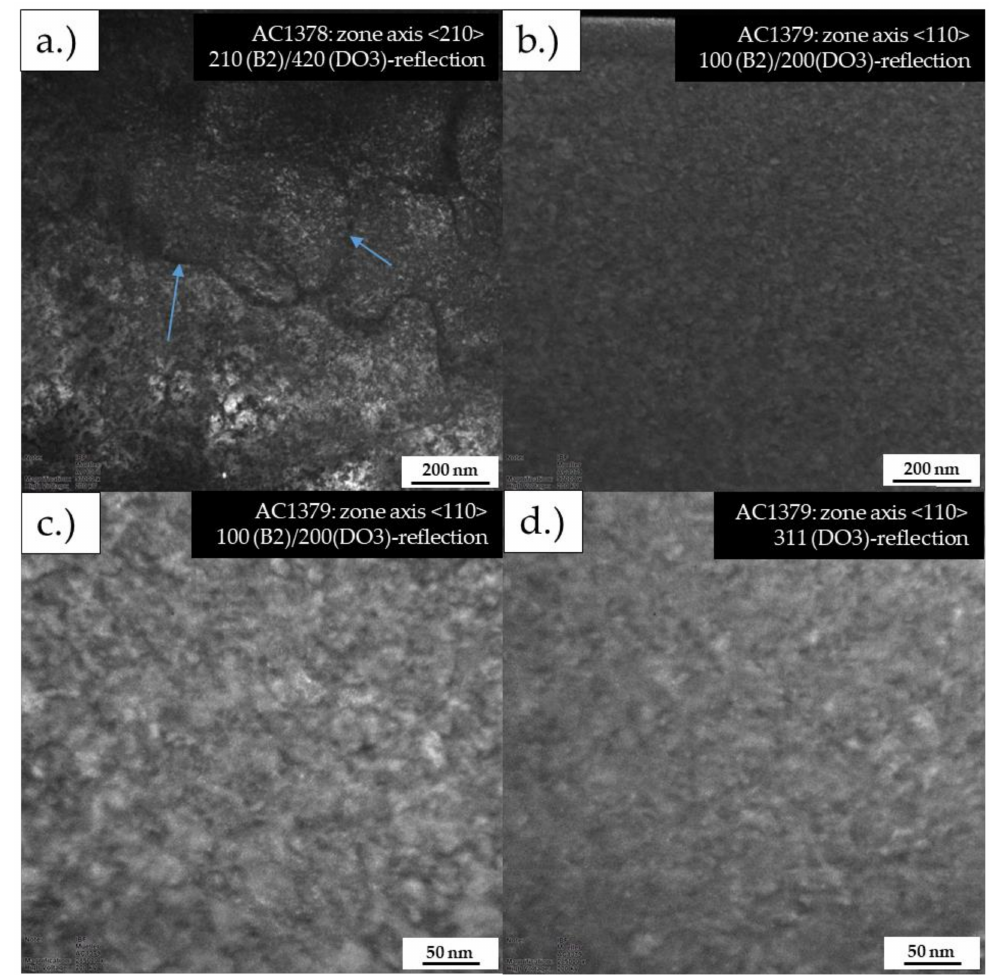
Figure 5. Dark field images received from TEM investigation: ( a ) AC1378 with a B2 and DO3 reflection; ( b ) AC1379 with a B2 and DO3 reflection; ( c ) magnified area of b with B2 and DO3 reflection and ( d ) same picture section as c with only DO3 reflection (Image source: GfE RWTH